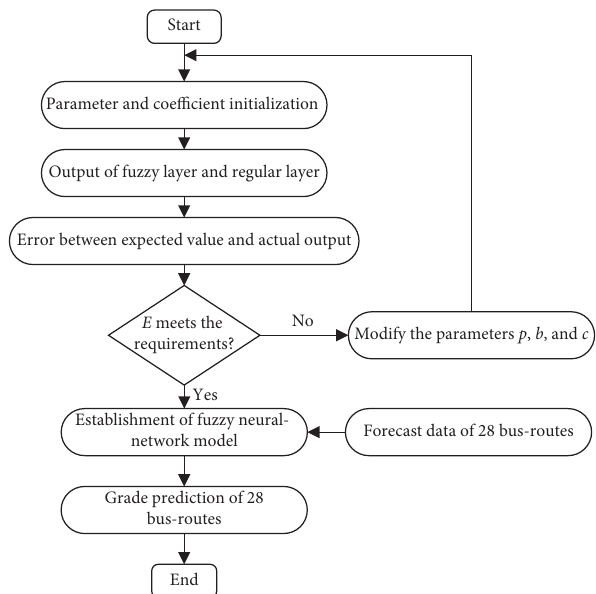
Figure 3: Algorithm flow of the fuzzy neural-network evaluation model for bus-line speed grade.